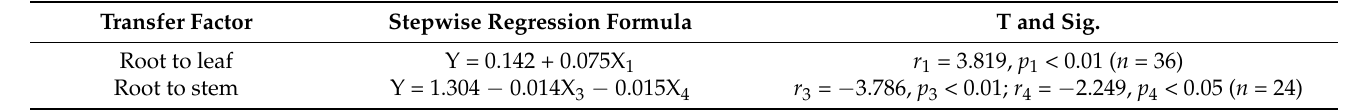
Table 3. Stepwise regression between TF of Cd (from root to leaf/stem) and percentages of different Cd chemical forms in